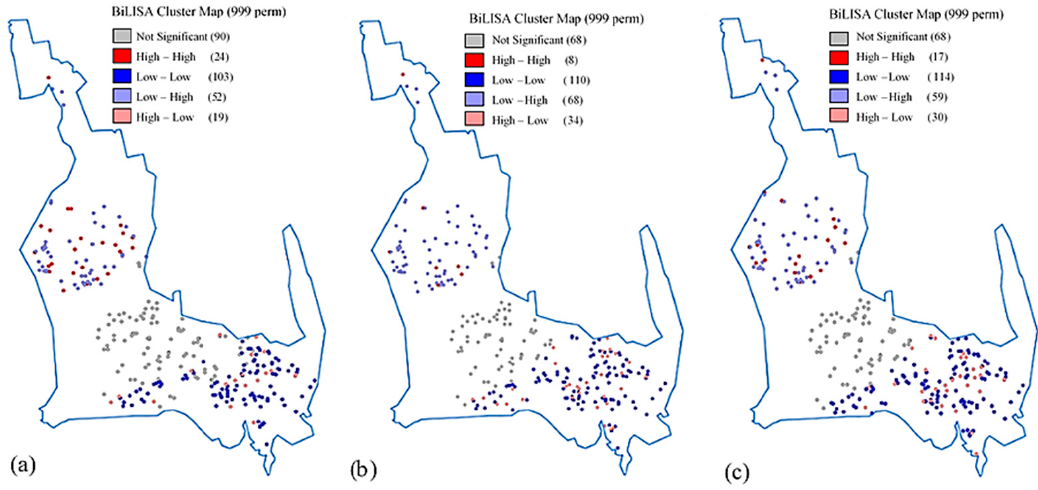
Figure 7. BiLISA clustering maps showing the spatial correspondence between cultivated areas and ( a ) Khlas, ( b ) Ruziz, and ( c ) Shishi cultivars as the number of trees.